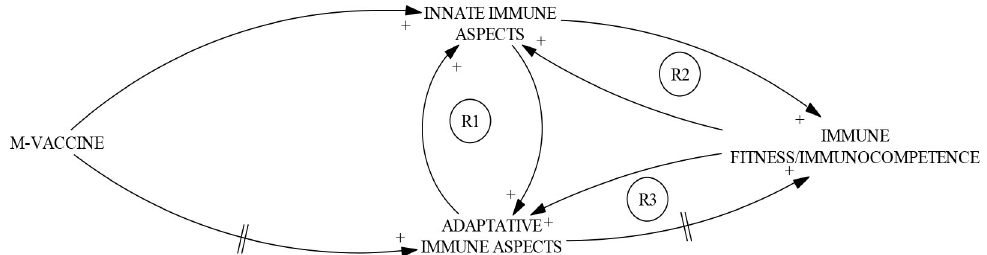
Figure 5. CLD represents immune buffer tuning by concurrent activation of innate and adaptative immune responses by an M-vaccine. The development of new types of vaccines with the capacity to activate; concurrently, the innate and adaptative immune compartments of the immune system is understood here as equivalent to the IT operation of buffer tuning, given the role of this NeTOp in enabling effective communication between well-defined sub-tasks. The CLD was inspired in Sánchez-Ramón et al. [22]. The action of two delay loops (//) can be noted, with the first representing the time lapse between vaccination and the development of the specific immune response, and the second representing the time necessary to generate a state of effective